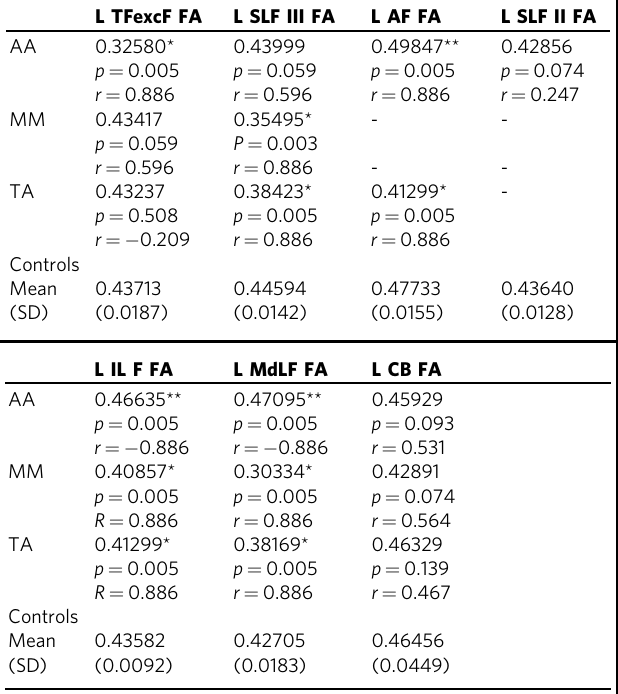
Fractional Anisotropy (FA) values of the left hemisphere Temporo-Frontal extreme capsule Fasciculus (TFexcF), Superior Longitudinal Fasciculus branch II (SLF ΙΙ ) and branch III (SLF ΙΙΙ ), Arcuate Fasciculus (AF), Inferior Longitudinal Fasciculus (ILF), Middle Longitudinal Fasciculus (MdLF) and Cingulum Bundle (CB), which was used as a control tract are also presented in the left hemisphere (LH) for the three patients and the control group ( n = 10), are presented. Mean FA and standard deviation (SD) of all white matter tracts included in the study are reported for thecontrolgroup.(-)Reconstructionfailureofthetractsbecauseoftheextensivedamageinthe white matter where they course resulting from the left CVA. P -values ( p ) as well as effect sizes ( r ) are calculated and presented for each participant and tract reconstruction. *Signi fi cantly lower FA values, as calculated with the use of the Wilcoxon signed rank test, with signi fi cance level set at 0.05. **Signi fi cantly higher FA values as calculated with the use of the Wilcoxon signed rank test, with signi fi cance level set at 0.05.